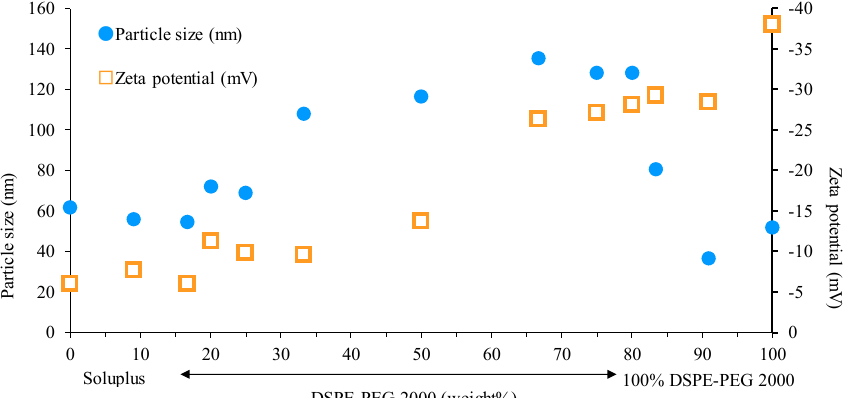
Figure 3. Relationship between zeta potential (ZP) and particle diameter on the different weight ratios of DPSE-PEG2000 and Soluplus nanoparticles.